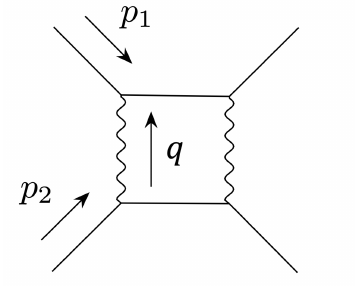
Figure 1 . Example of a box diagram that appears within the ladder diagrams contributing in the eikonal limit. Here, the gravitons correspond to the rungs of the